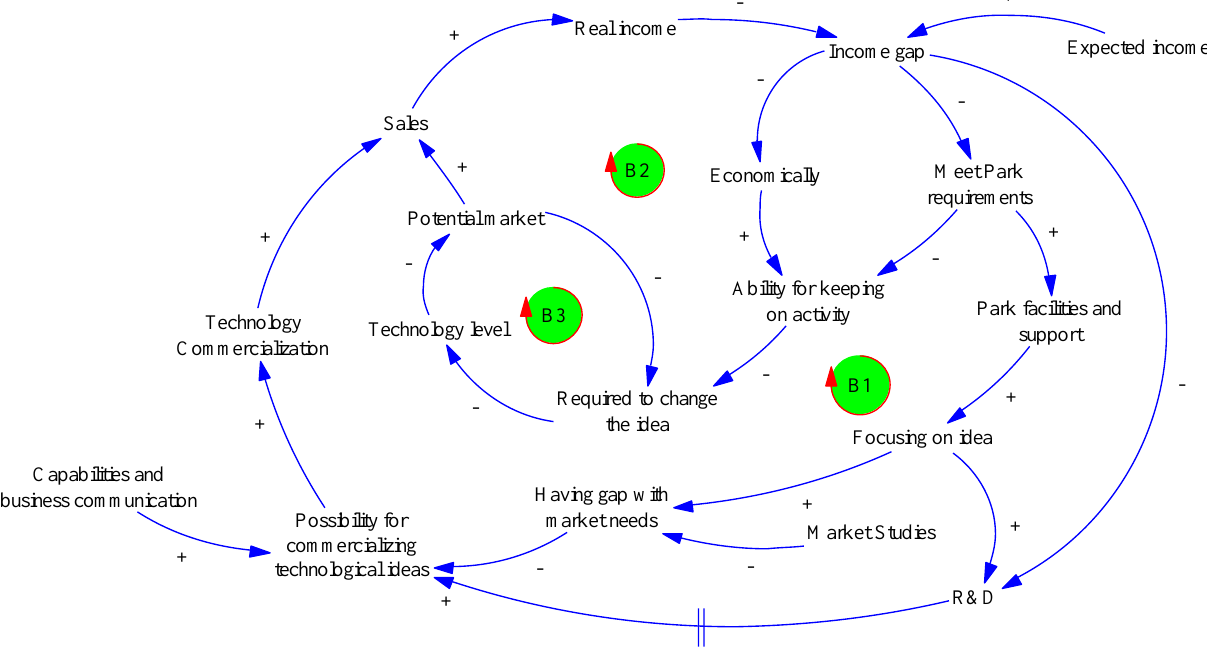
Figure 5. Loop of initial technological idea change, due to lack of market